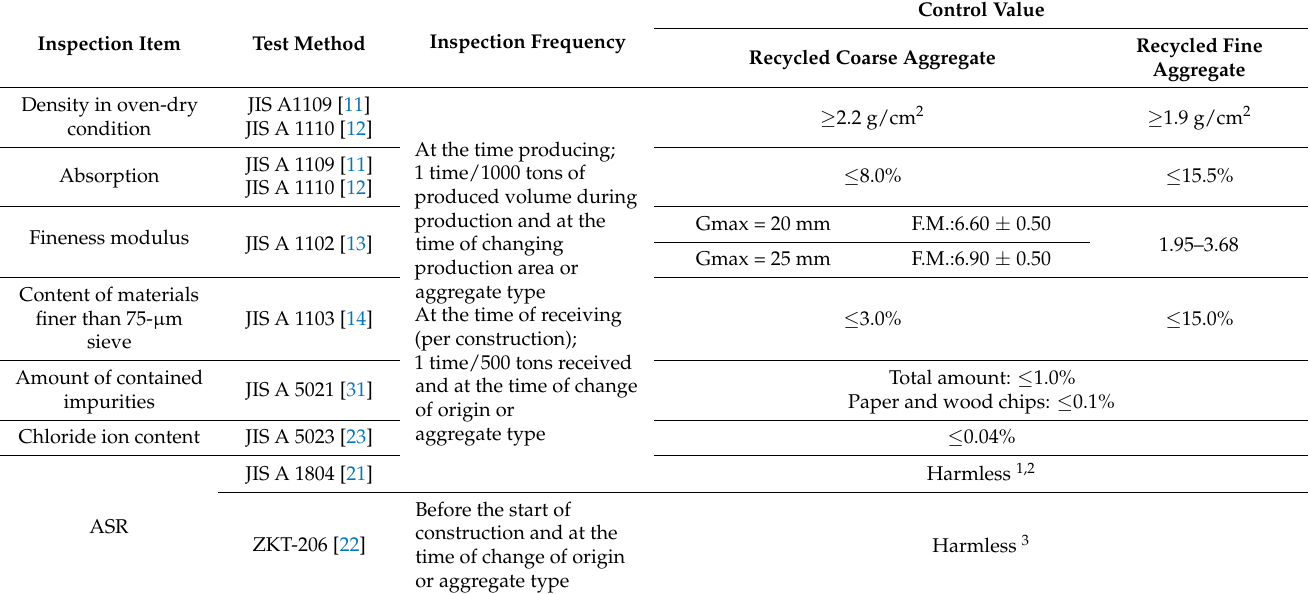
Table A1. Quality standard of recycled aggregate